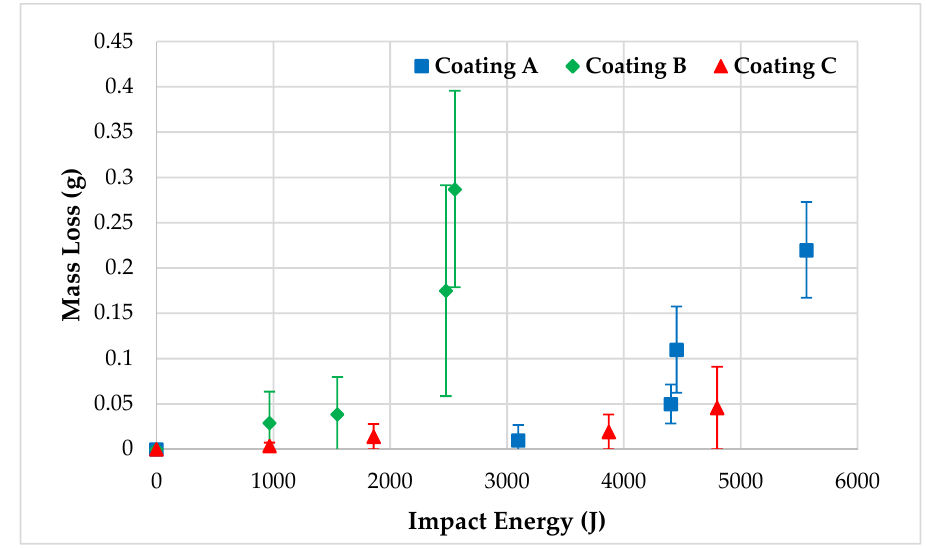
Figure 15. Sample mass loss with impact energy.